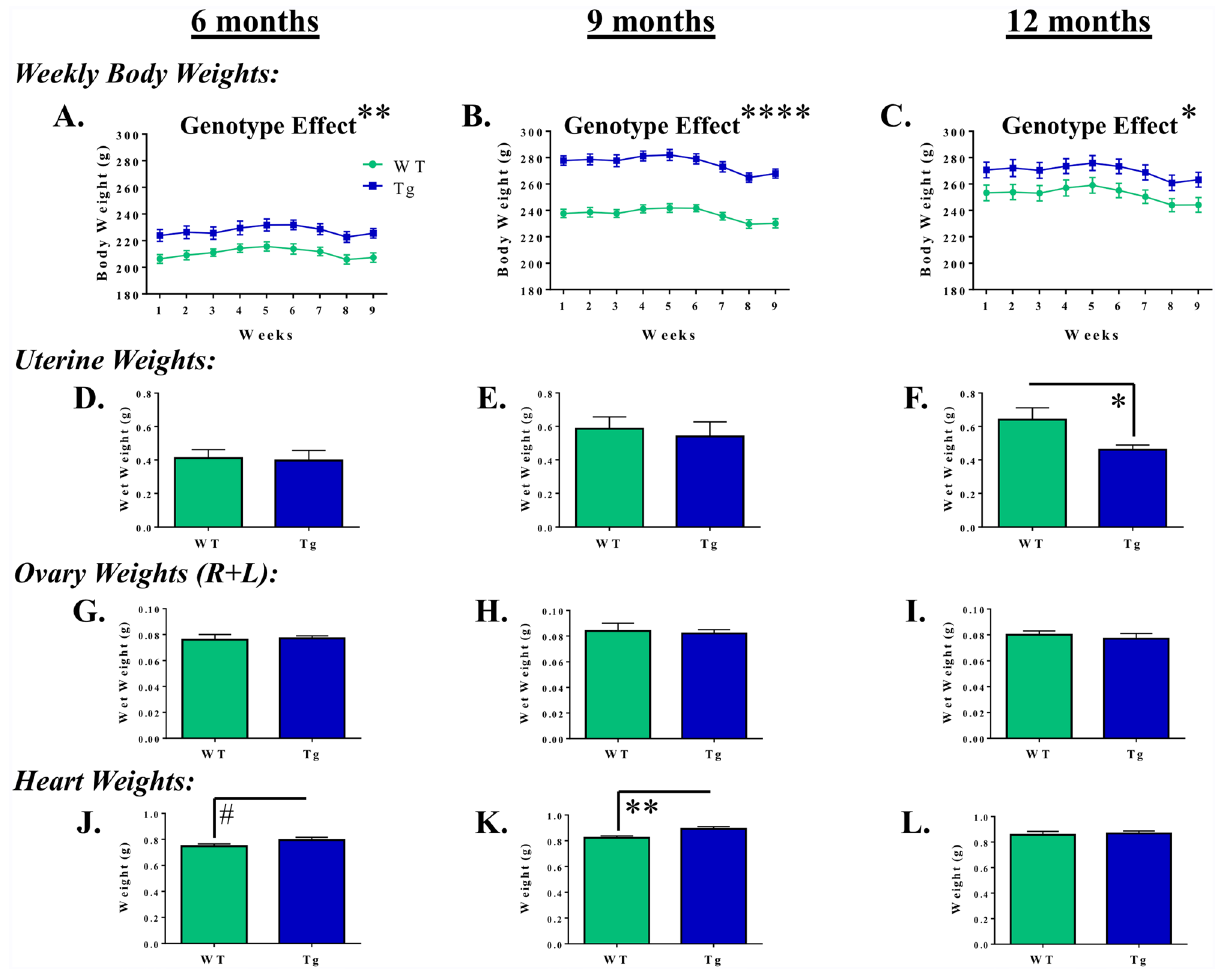
Figure 7. Distinct age-dependent physiological profiles in the TgF344-AD rat. ( a – c ) Weekly body weights collected across the course of the study indicate that, regardless of age, Tg rats weighed more than their WT counterparts. * p < 0.05, ** p < 0.01, **** p < 0.0001. ( d – f ) Analyses of uterine weights collected at sacrifice demonstrated that, uniquely at the 12-month timepoint, Tg rats had reduced uterine weights as compared to WT controls. * p < 0.05. ( g – i ) Analyses of ovary weight (R + L) at sacrifice revealed no effect of Genotype at any age-point. ( j – l ) Analyses of heart weight demonstrated a marginal effect of Genotype at 6 months and a significant effect at 9 months, where Tg hearts weighed more than WT hearts. # p < 0.10, ** p <